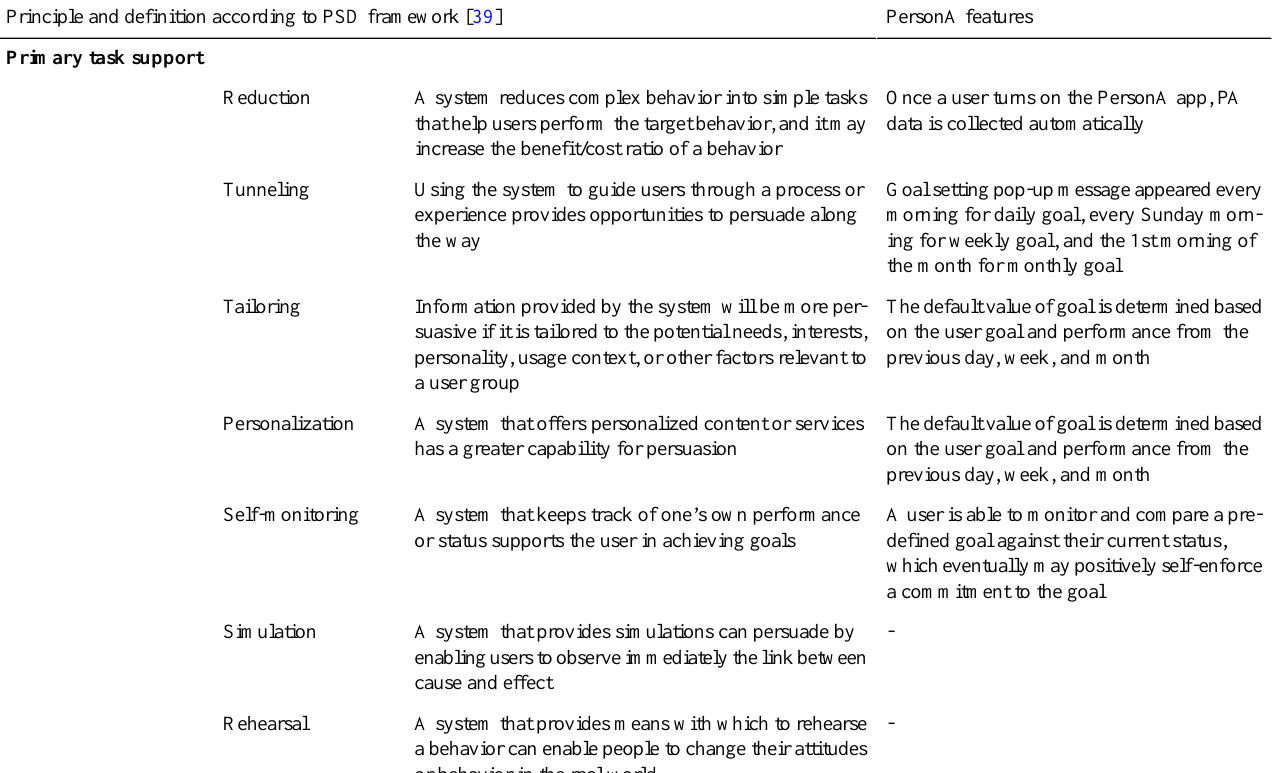
Table 2. PSD framework elements and PersonA